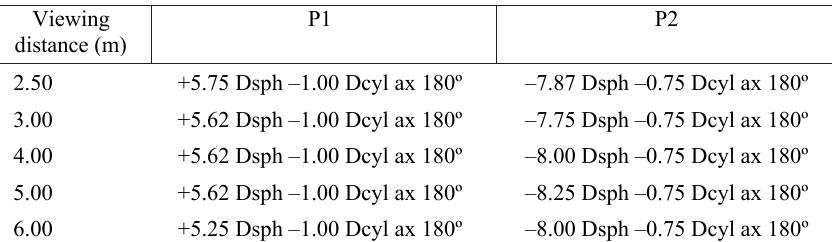
Table 2. Subjective refraction of two participants (P1 and P2) with the best corrected visual acuity 0.8 (decimal units). They were not included in the overall